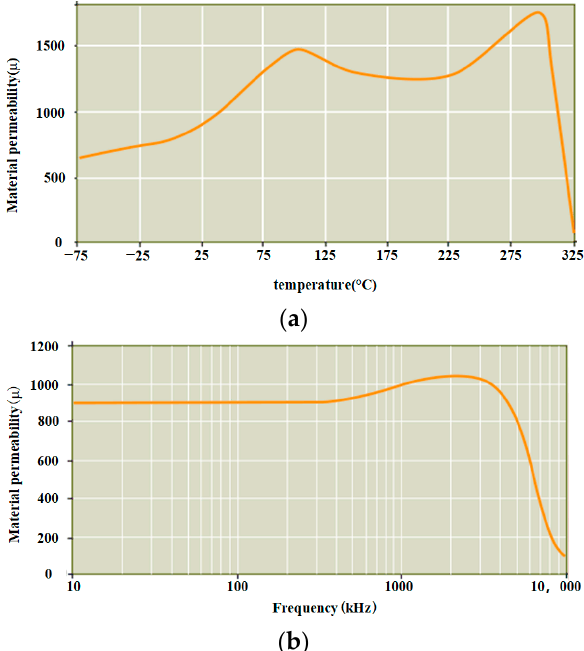
Figure 4. The change of permeability of L material: ( a ) L Relationship between material permeability and temperature; ( b ) L Relationship between material permeability and frequency.